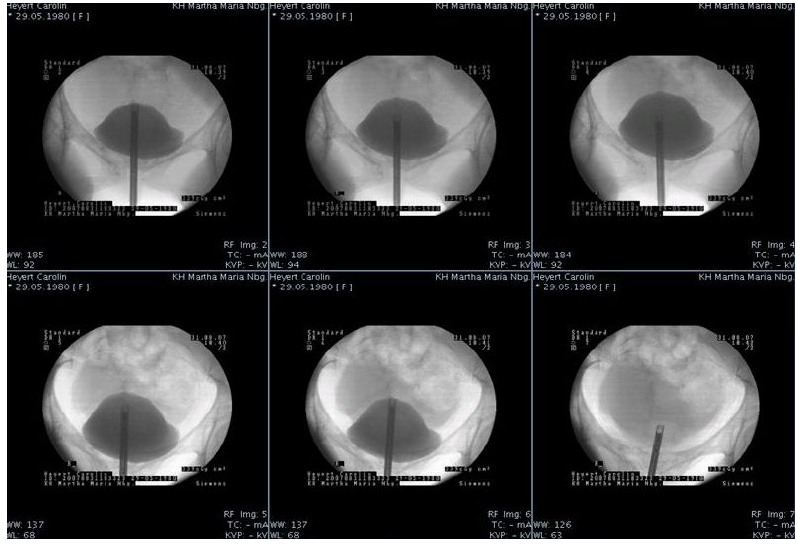
FIGURE 1. Cystogram showing a gradual massive intraperitoneal extravasation of contrast